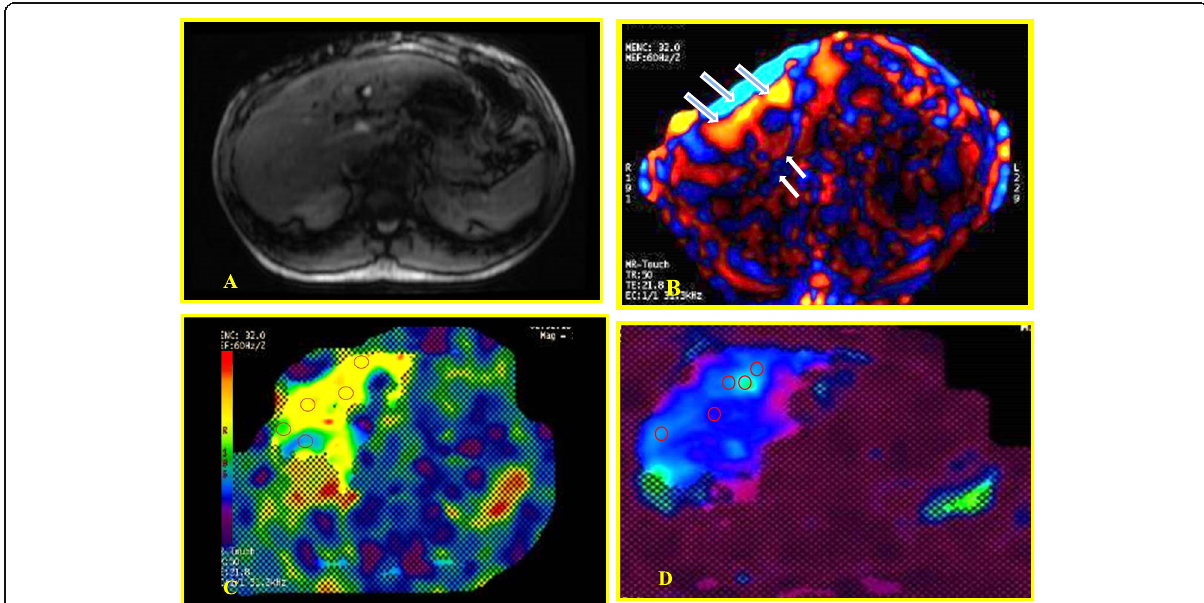
Fig. 6 a – d Demonstrates MRE sequence images of a 45-year-old apparently normal LLD candidate with hepatic fibrosis of F2 stage, according to METAVIR score of fibrosis, and the estimated mean stiffness of the liver was 2.58 kPa. The obtained MRE sequence images include the conventional anatomical reference image of MRE single slice ( a ) and the corresponding shear wave images ( b ), as well as the color-coded confidence map images with 0 – 8 kPa and 0 – 20 kPa ( c and d , respectively). The conventional anatomical reference image ( a ) reveals apparently normal hepatic tissue, while the analysis of the corresponding colour-coded shear wave image ( b ) show very thick, wide, and irregular, and longer wave length throughout the liver, particularly in the right hepatic lobe (the arrows in image b ). Moreover, the valid area for hepatic stiffness estimation in color-coded confidence map with 0 – 8 kPa ( c ), mainly stained with yellow colour on a light greenish-blue background ( d ), while it displays light green color on a light blue background on confidence map with 20 kPa ( e ). According to the corresponding color bars, these colors represent increased tissue stiffness with the mean estimated stiffness values of the liver in the ROIs, on confidence maps (red and yellow rings on c and d images, respectively) was 2.58 kPa (stiffness of F2 stage of fibrosis). Moreover, the liver biopsy confirmed these findings